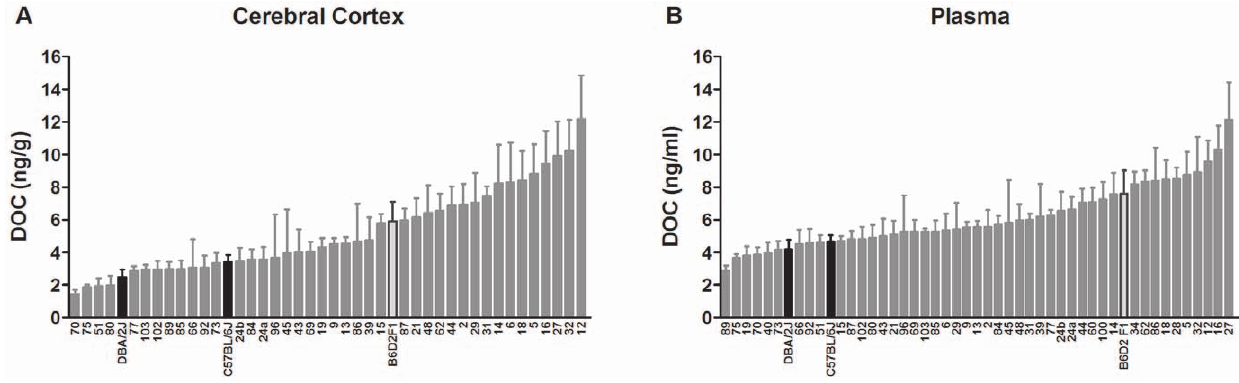
Figure 1. Variation in basal DOC levels across the BXD strains. Mice were injected with saline at 8:00 am and were sacrificed 6 hours later. Data are expressed as ng/g (cerebral cortex) or ng/ml (plasma) and are means 6 SEM of values from 2–9 mice per strain. The x axis reports the BXD strain number; C57BL/6J (B6), DBA/2J (D2) and B6D2 F1 hybrid are also indicated. Strains are plotted in order from the lowest to the highest DOC levels for cerebral cortex (42 BXD strains) or plasma (47 BXD strains), respectively. One-way ANOVA was used to estimate significant genetic variation.